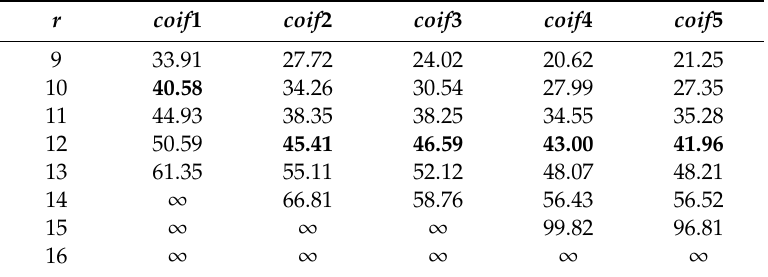
Table 25. Experimental results ( PSNR , dB) of 3D tomographic 8-bit image “wmri” DWT by using bit-width r of coiflets filters coe ffi cients.